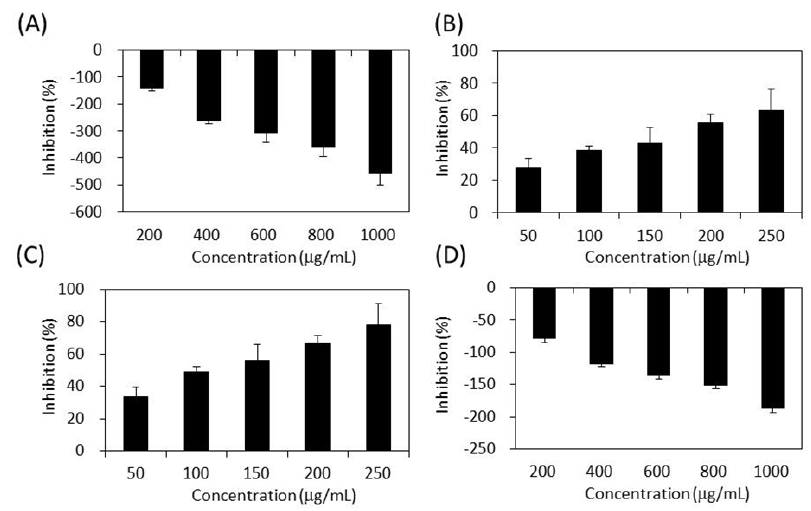
Figure 5. Inhibitory activities of S. orientalis extracts on α-amylase. ( A ) SE; ( B ) SE-Hex; ( C ) SE-EA; and ( D ) SE-MeOH.